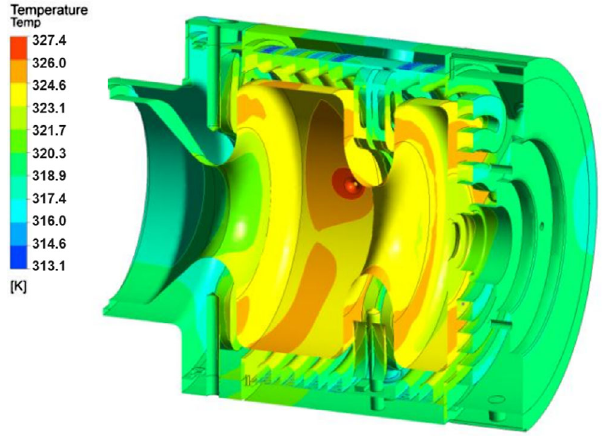
FIG. 16. Simulated temperature profile at the photoinjector cavity surface.